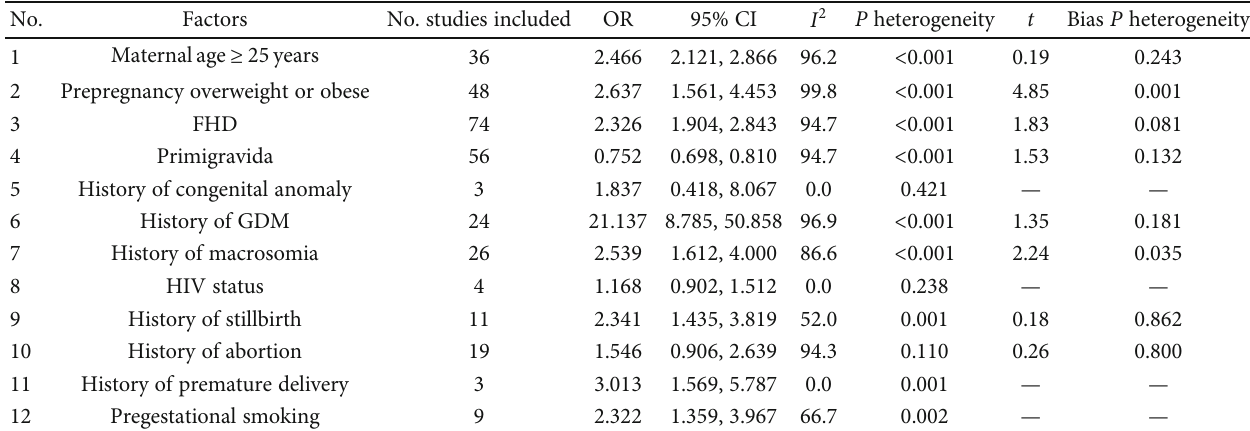
Table 2: Summary of the meta-analysis of associated factors for